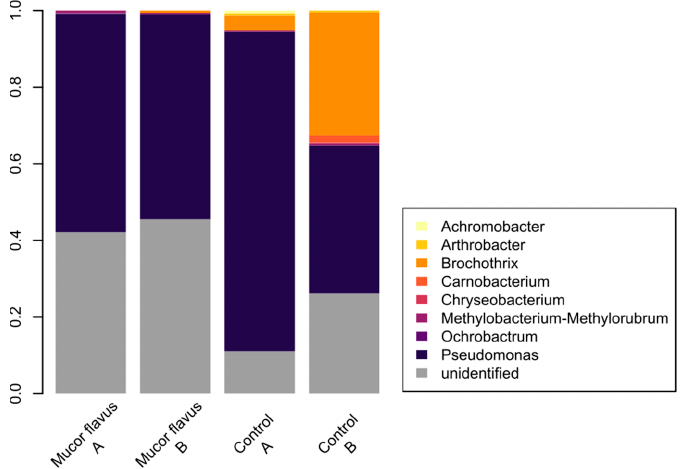
Figure 7. Relative abundance in (%) of bacterial communities at genus level in control samples and in samples inoculated with M. flavus biostarter.